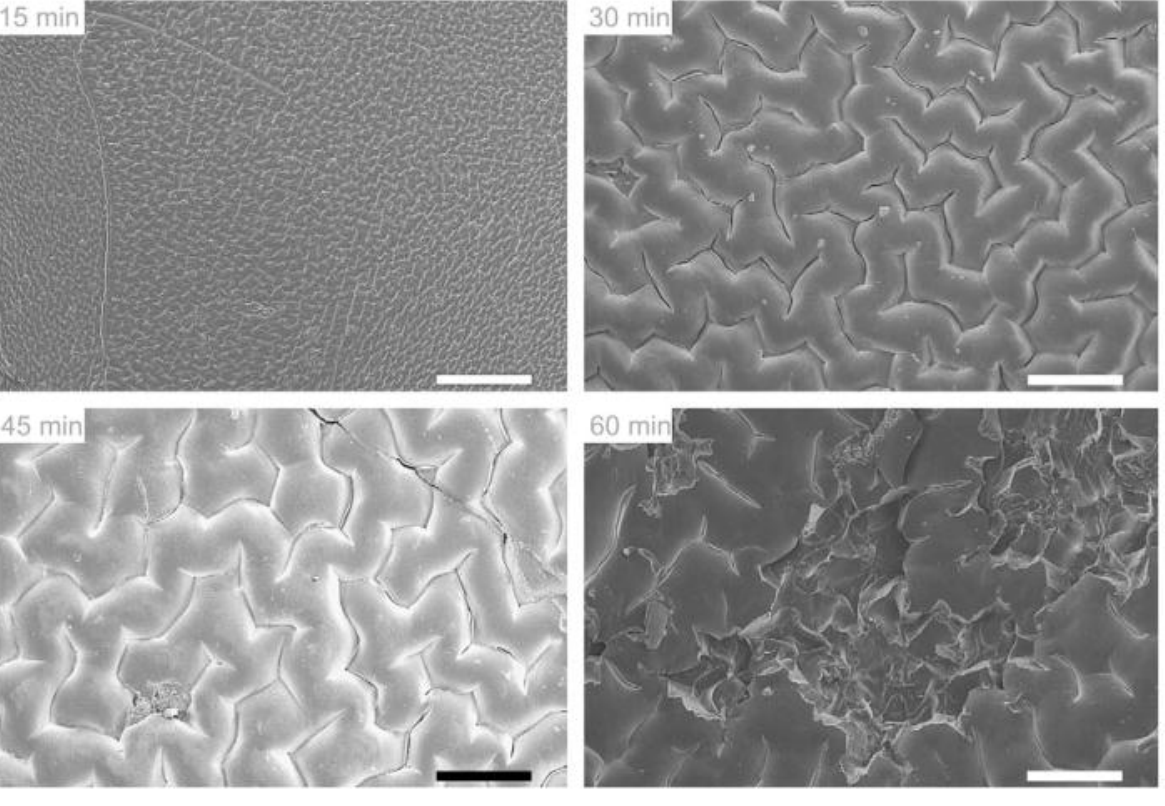
Figure 5. Scanning electron micrographs of octadecyl isocyanate-modified pHEMA surfaces after 15, 30, 45, and 60 min. The 15-min reaction time shows a low-amplitude reticulated pattern, while longer times show increasing crevasse size and surface damage. Scale bars are 200 μ m. Reproduced from reference [23] with permission of